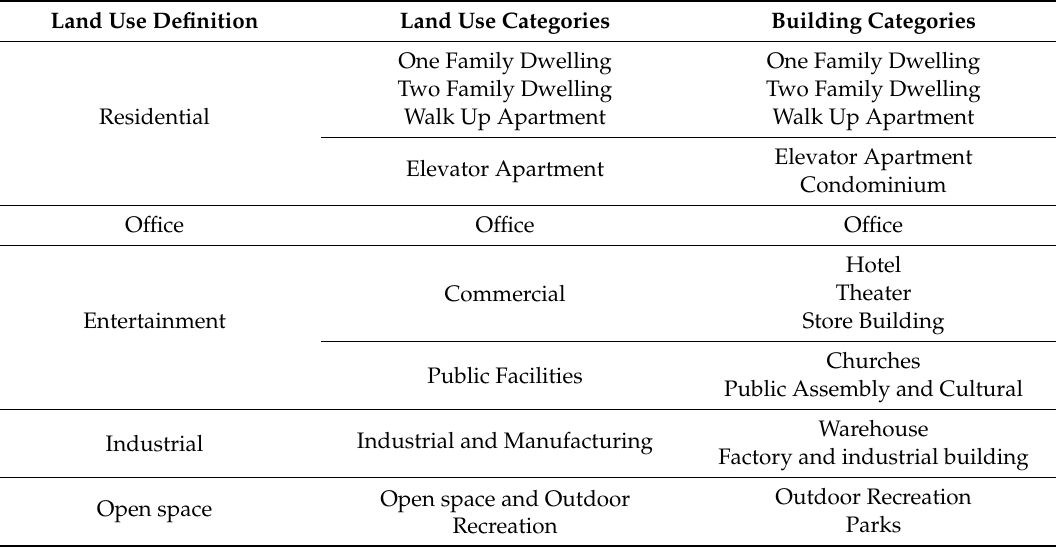
Table 1. Definitions of land use with land use and building categories.